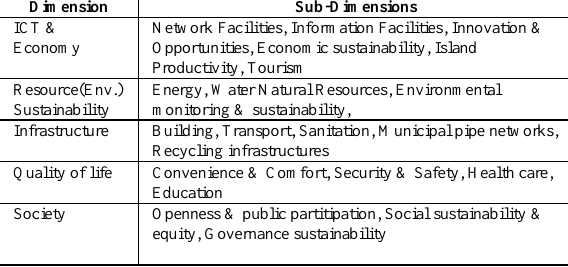
Table 2. Main dimensions and sub-dimensions of the proposed KPI scheme for Smart Sustainable Islands Index (S 2 I 2 ) The proposed S 2 I 2 scheme is summarized in Figure 2.